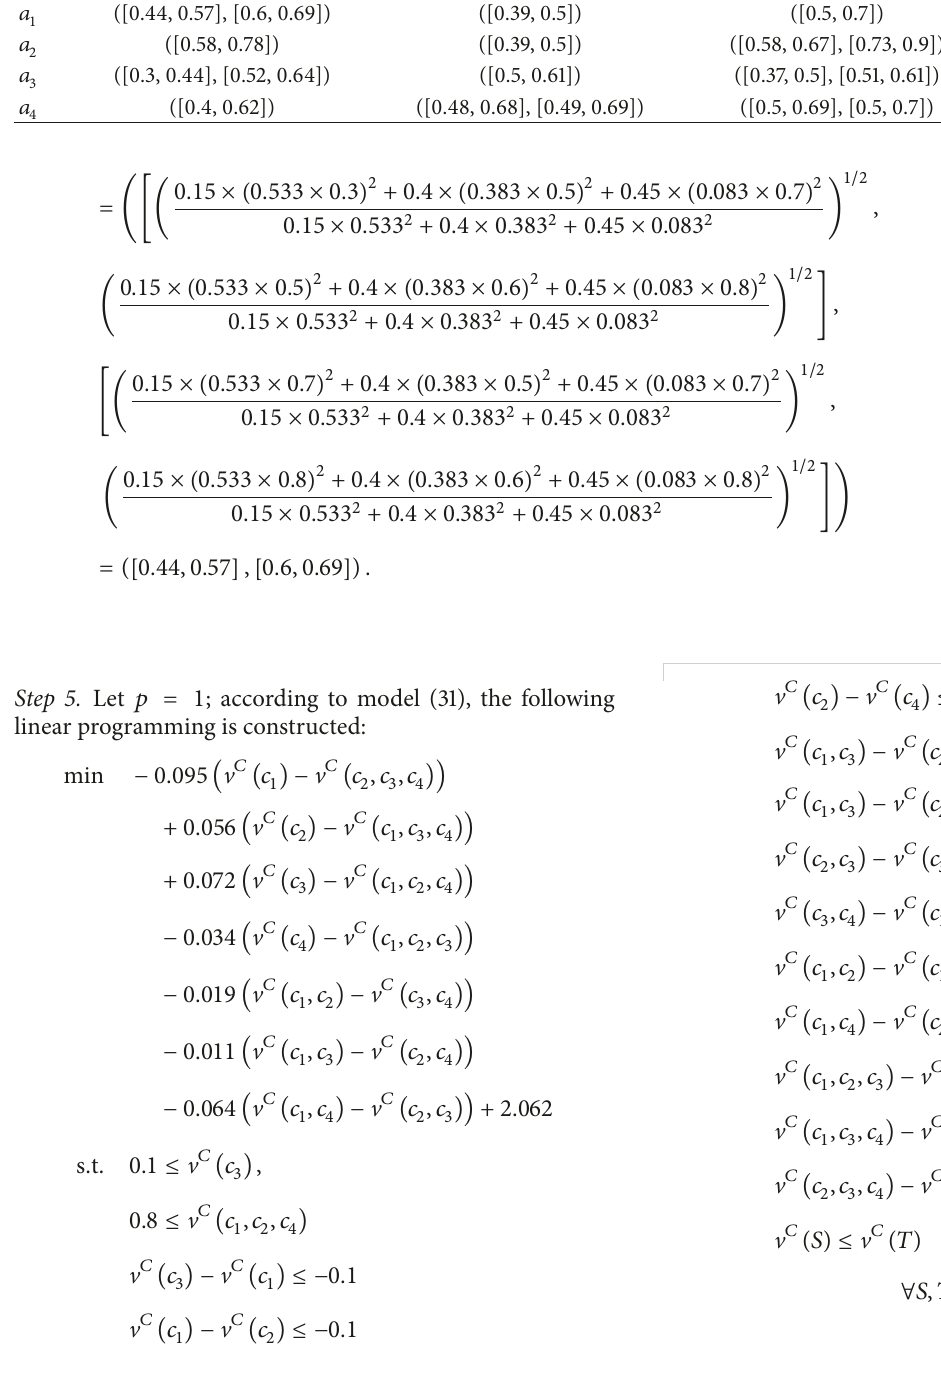
Table 7: The Shapley weighted matrix 𝐻